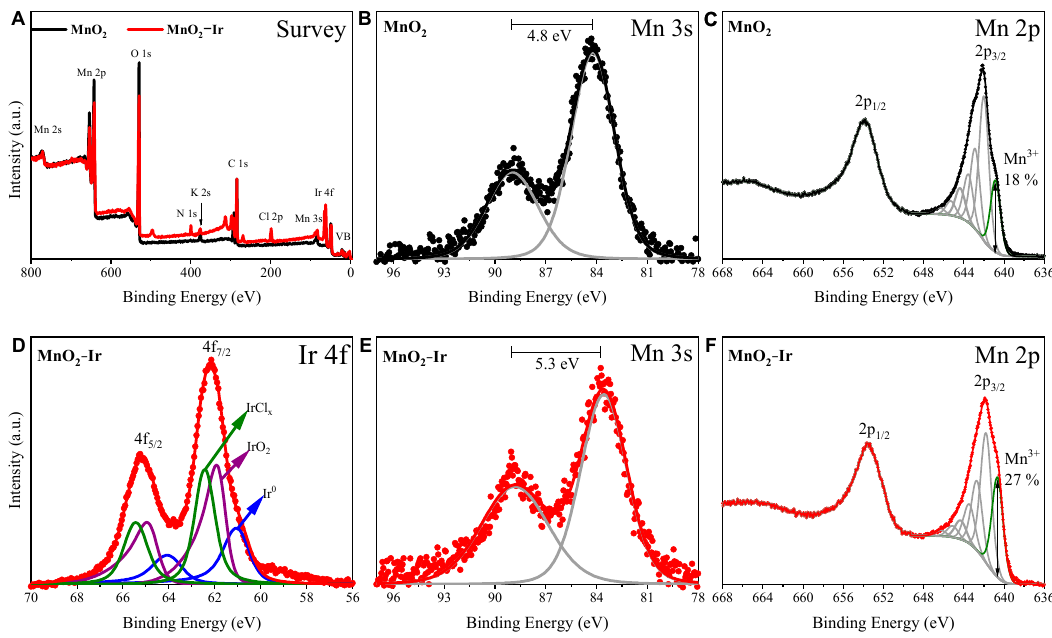
Figure 4. ( A ) XPS survey spectra of MnO 2 and MnO 2 -Ir (black and red curves, respectively). ( B , E ) Mn 3s for MnO 2 ( B ) and MnO 2 -Ir ( E ), ( C , F ) Mn 2p for MnO 2 ( C ) and MnO 2 -Ir ( F ), and Ir 4f for MnO 2 -Ir ( D ) core-level spectra.